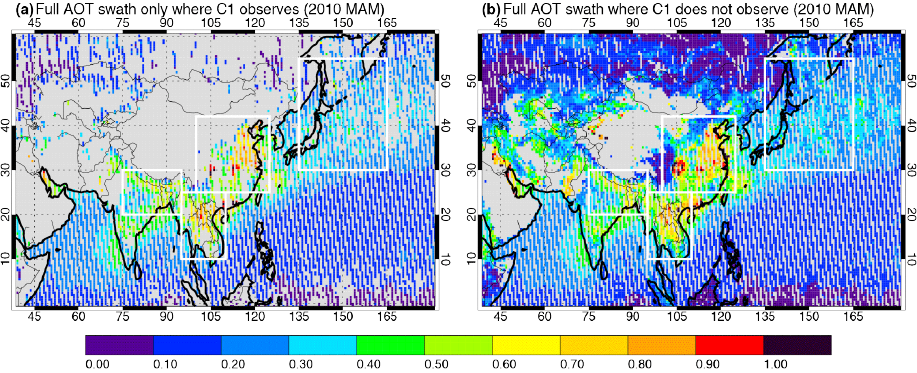
Figure 8. As in Fig. 7, but for the C1 sub-sampling mask for March-April-May 2010 over Asia. The full-swath seasonal mean AOT is shown both where the C1 sub-sample does (a) and does not (b) have a valid seasonal mean. The white boxes outline regions discussed in the